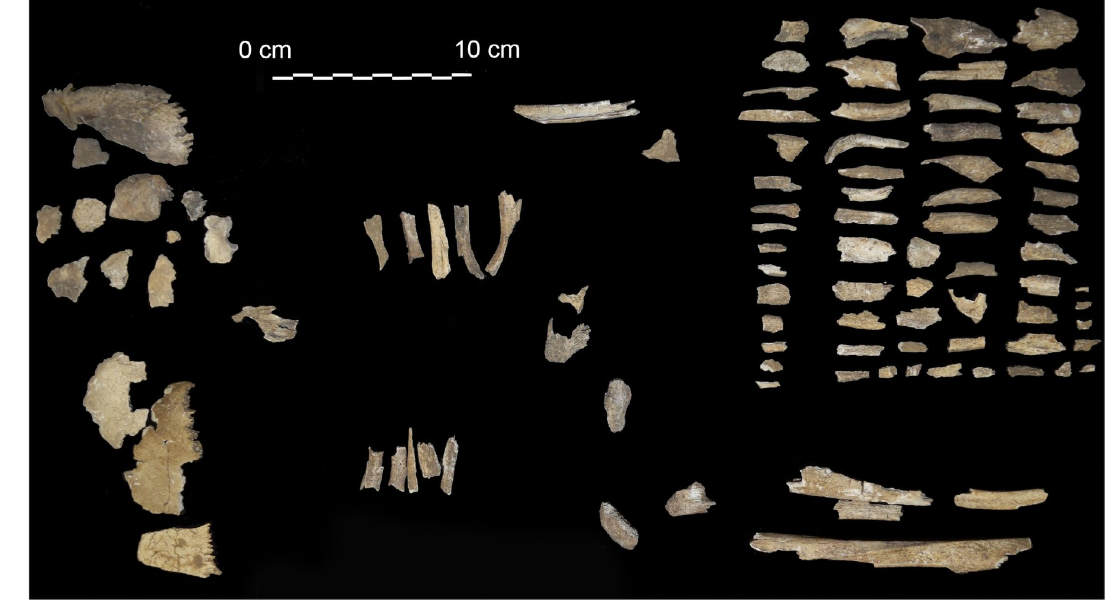
Fig 5. The human fragments from the Tomb of Nestor’s Cup. Bone and dental fragments recognized as human by the gross morphology observations.